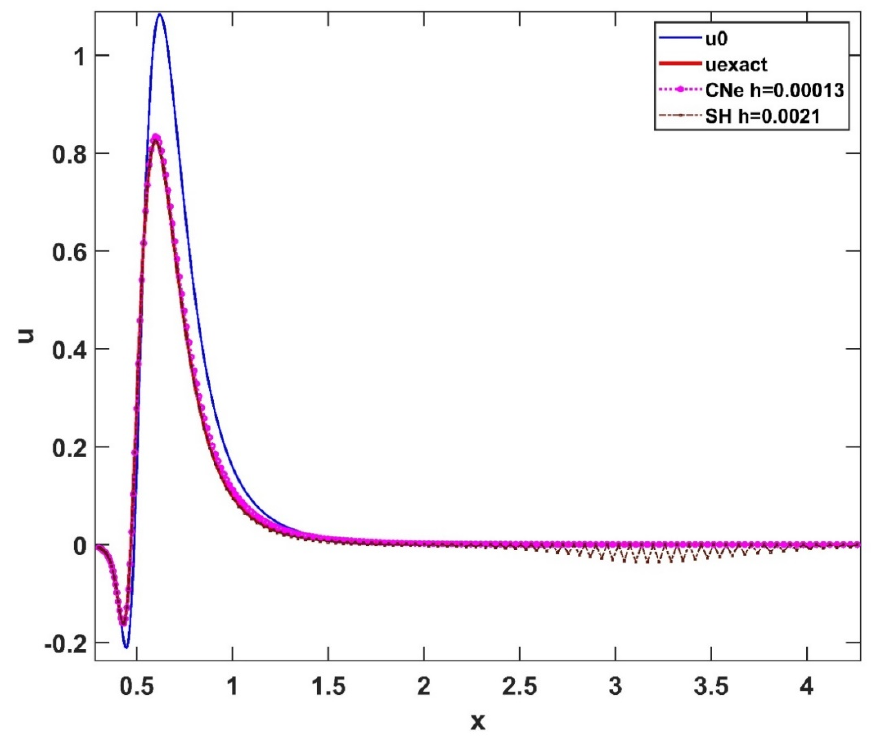
Figure 15. The concentration u as a function of the x variable in the case of the initial function u 0 , the analytical solution at t fin , the CNe method for h = 1.3 · 10 − 4 , and the SH method for h = 2.1 · 10 − 3 . The SH curve almost coincides with the exact one for small values of x , whereas this is true for the CNe curve for large x . The CFL limit for the standard RK4 method is approximately h ≈ 3.2 · 10 − 8 . We can see that there are two completely different types of difficulties in this